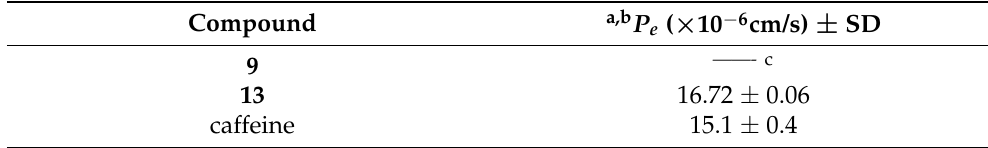
Table 6. Permeability coefficient of compounds 9 and 13 and caffeine.